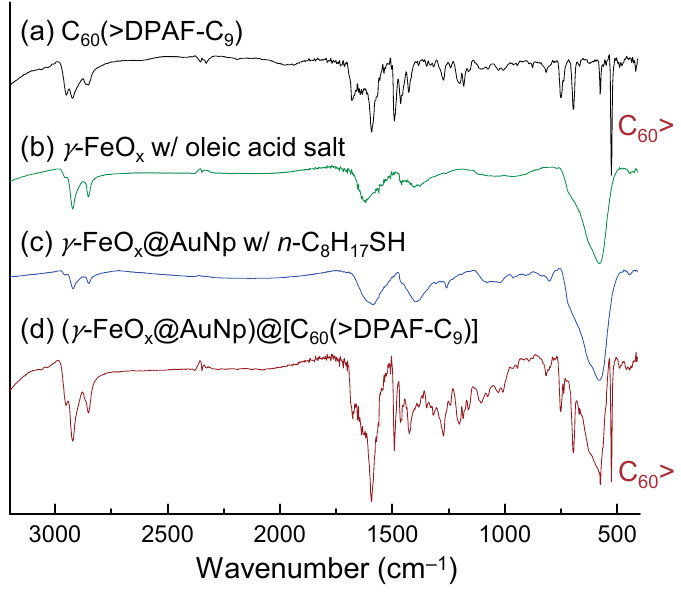
Figure 4. Infrared absorption spectra of four samples indicated, showing a consecutive sum of absorption bands on final product 3 – 1 in ( d